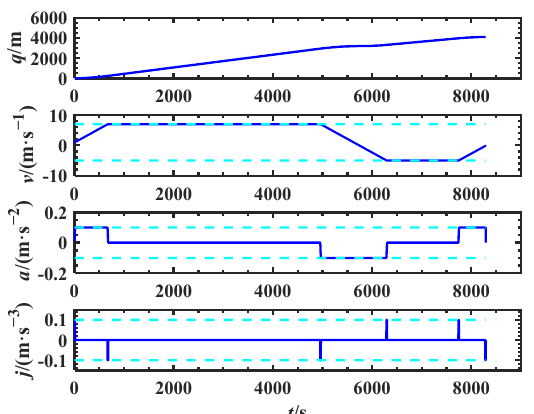
Figure 16. Planned profiles for position, velocity, acceleration, and jerk including backward motion.